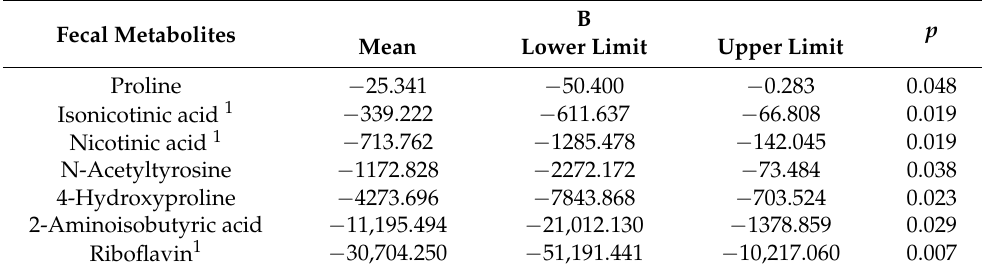
Figure 4. Association of breastmilk Bacteroides with infant waist circumference aged 1 year and pre-pregnancy maternal weight. ( a ) Boxplot of infant waist circumference aged 1 year based on tertiles of breastmilk Bacteroides . Bacteroides _low indicates the lowest tertile and Bacteroides _high indicates the highest tertile. ( b ) Boxplot of relative abundance of breastmilk Bacteroides based on the median of pre-pregnancy maternal weight. The mWeight_low group includes newborns with pre-pregnancy maternal weight below the median, and the mWeight_high group includes newborns with pre-pregnancy maternal weight above the median (Mann–Whitney U test, * p < 0.05). Table 2. Association of fecal metabolites with infant waist aged 1 year.